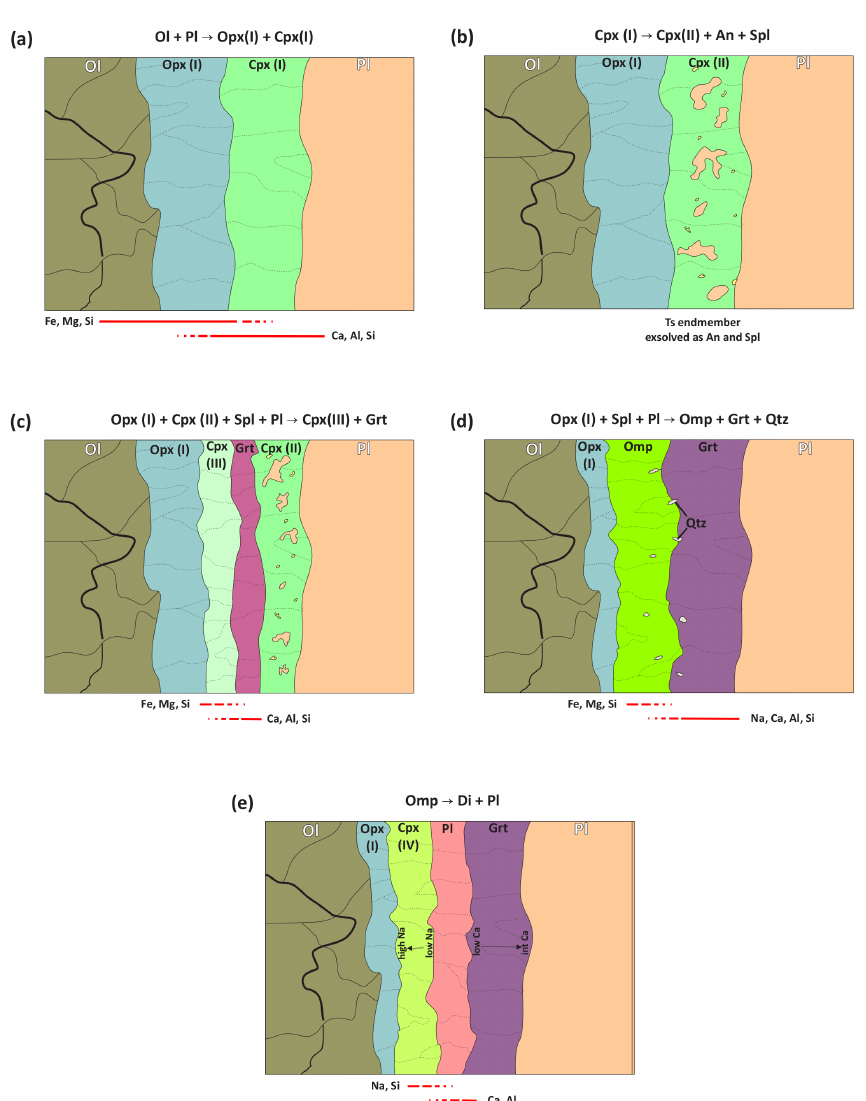
Figure 3. Multi-stage sequential layer development in a corona between olivine and plagioclase formed in response to changing P and T along the P – T path shown in Fig. 2 (after Griffin, 1972). (a) Original olivine and plagioclase react to form orthopyroxene and clinopyrox- ene. (b) Clinopyroxene breaks down to form a less Tschermakitic composition with plagioclase and spinel. (c) Clinopyroxene reacts with orthopyroxene, spinel and plagioclase to produce garnet. (d) Orthopyroxene reacts with spinel and plagioclase to produce omphacite, garnet and quartz. (e) Omphacite decomposes to clinopyroxene and